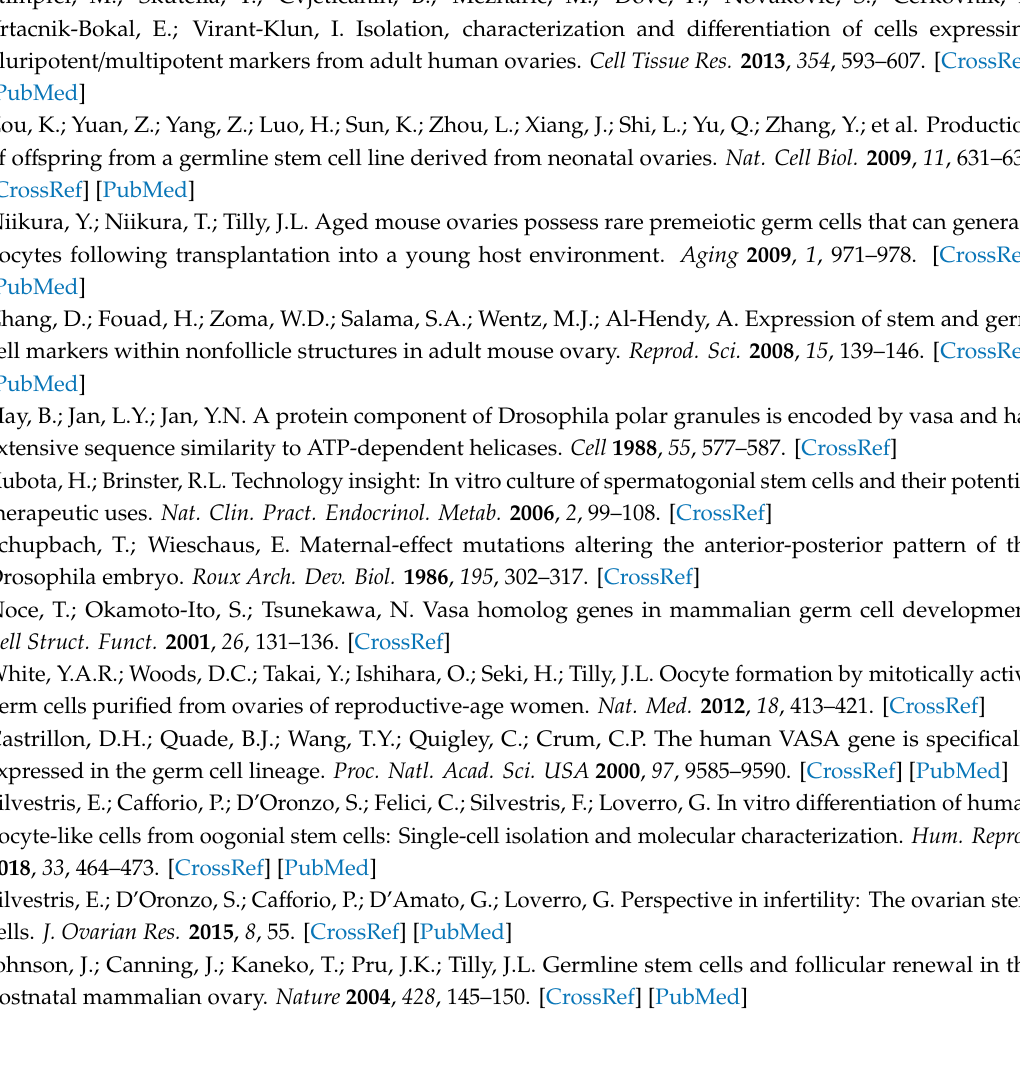
Table S1: The debate on either existence (A) or inexistence (B) of OSCs. (A) Studies supporting the existence of the OSCs. (B) Studies denying the existence of the